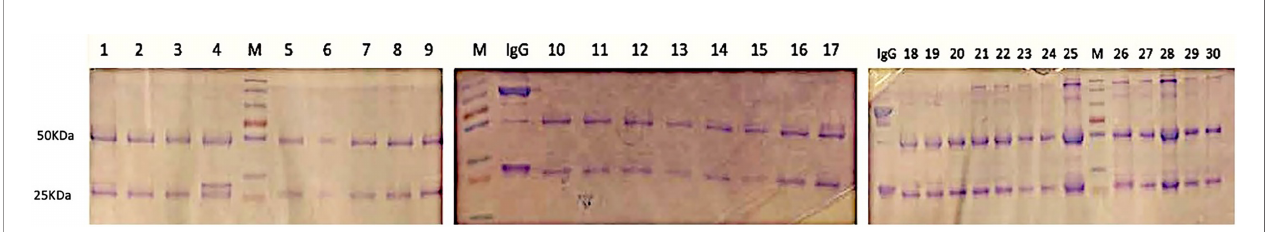
FIGURE 1 | SDS-PAGE analysis of IgG purity from plasma with Protein G resin and acidic elution. Numbers 1-30 indicated the position of the corresponding sample. M, molecular weight marker. SDS-PAGE results to determine the purity of puri fi ed IgG showed a distinct band of 50 kDa. Molecular weight marker position corresponds to Ab heavy chain, and the band in 25 kDa position corresponds to IgG light chain.